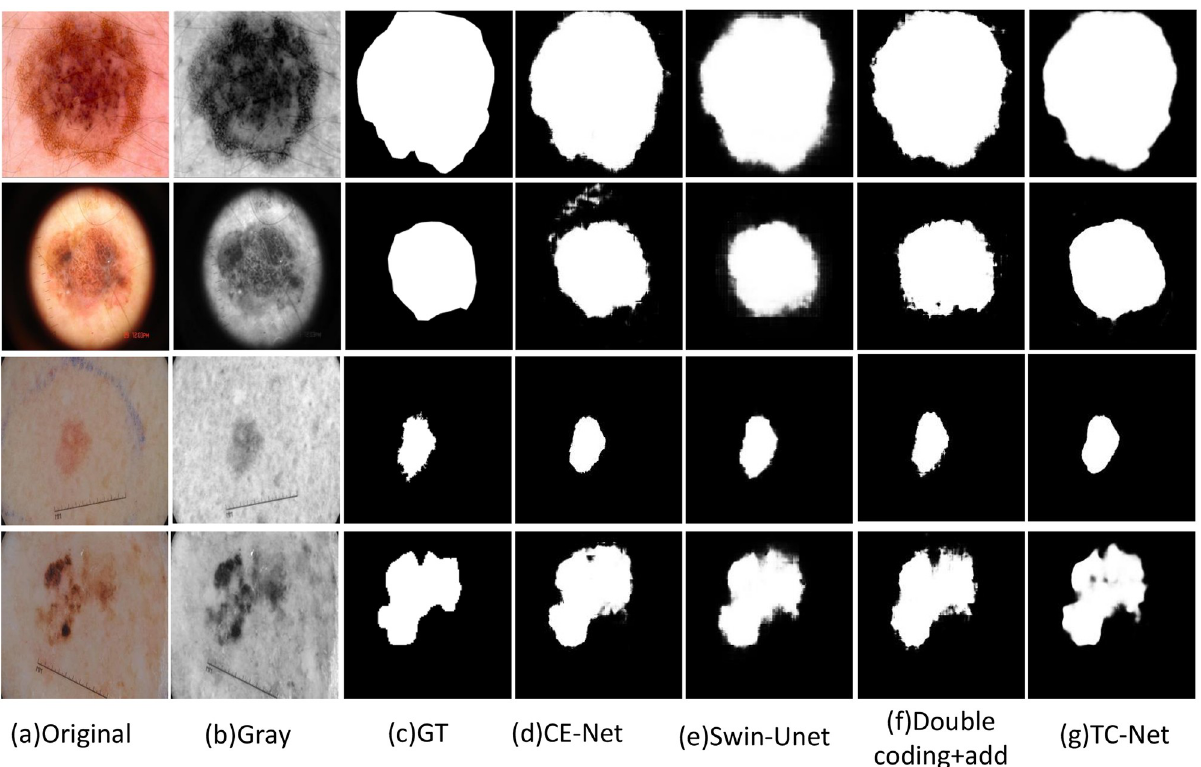
Fig 5. Visual analysis of ablation experiment on ISBI2016. (a) Original. (b) Gray. (c) GT. (d) CE-Net. (e) Swin-Unet. (f) Double coding+add. (g) TC-Net.